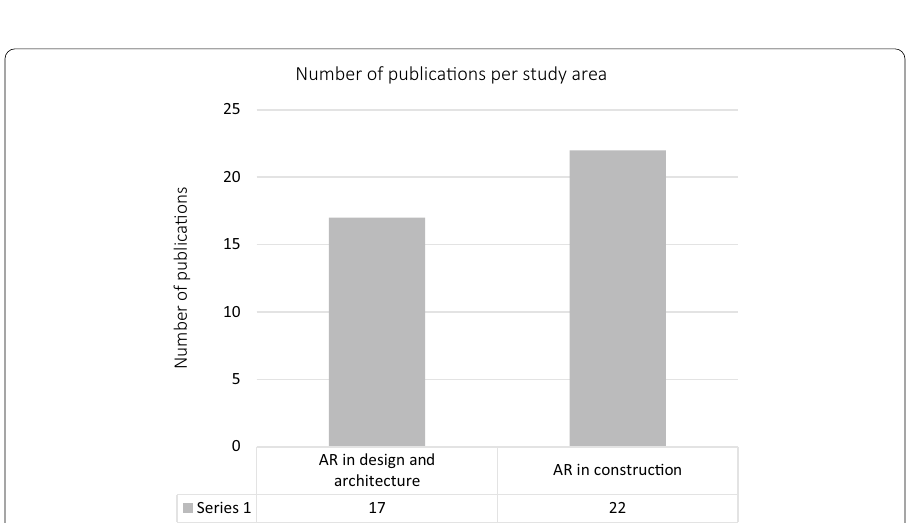
Fig. 5 Sources of the selected publication